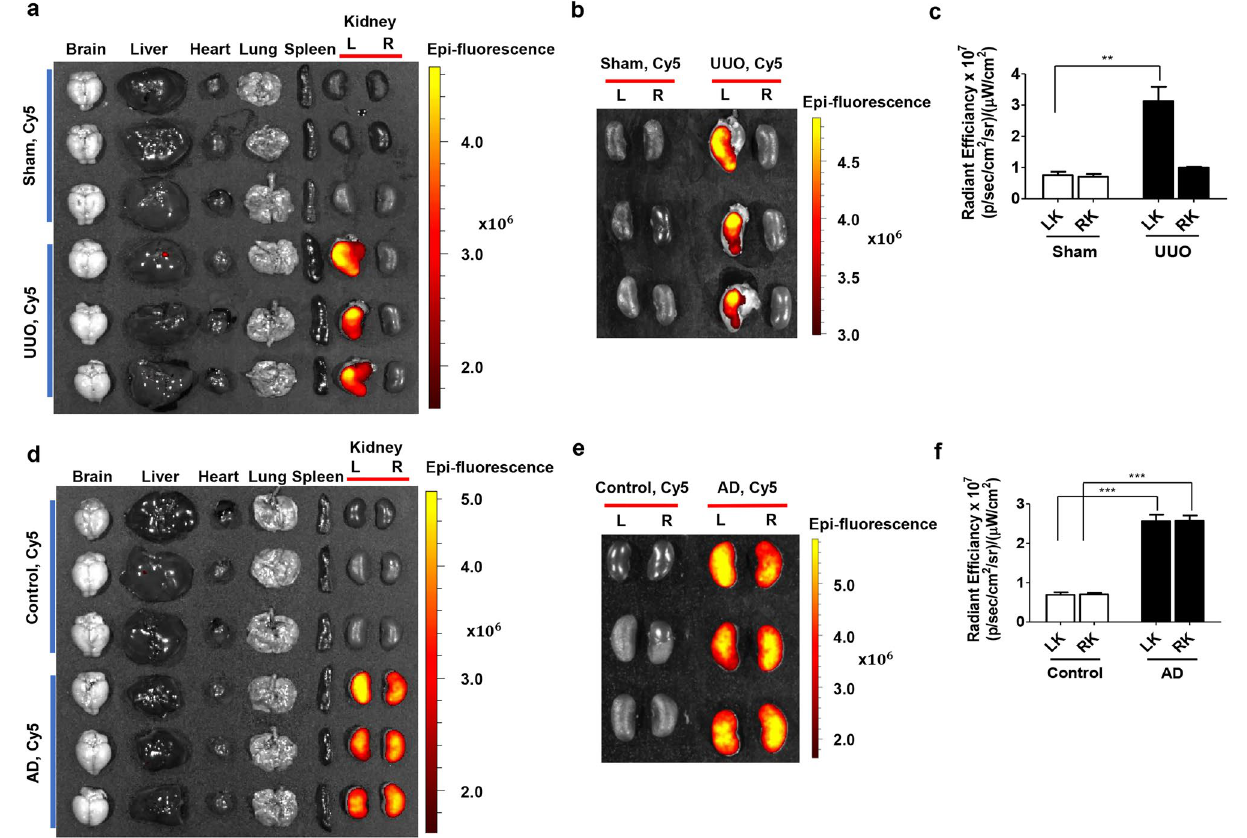
Figure 5. In vivo biodistribution of Cy5-labeled SAMiRNA-AREG in murine UUO- or AD-induced model of renal fibrosis. ( a ) Mice subjected to sham operations or 1 week after UUO were administered Cy5-labeled SAMiRNA-AREG via i.v. injection. Ex vivo fluorescent imaging was performed on organs including the brain, liver, heart, lung, spleen, and kidneys (L, obstructed, R, unobstructed) 48 h after the injection of Cy5-labeled SAMiRNA-AREG to sham or UUO mice, showing the Cy5 signal confined to the renal region. ( b ) Ex vivo fluorescent imaging of Cy5 signal from sham or UUO kidneys 48 h after the injection of the Cy5-labeled SAMiRNA-AREG. ( c ) Quantification of fluorescence intensity in the obstructed (LK) or unobstructed (RK) kidneys. ( d ) Mice fed a normal diet or 1 week of AD were subcutaneously injected with Cy5-labeled SAMiRNA- AREG. Ex vivo fluorescent imaging was performed on organs including the brain, liver, heart, lung, spleen, and kidneys 48 h after the injection of Cy5-labeled SAMiRNA-AREG to control or AD mice, showing the Cy5 signal confined to the renal region. ( e ) Ex vivo fluorescent imaging of Cy5 signal derived from control kidneys or AD model kidneys 48 h after the injection of Cy5-labeled SAMiRNA-AREG. ( f ) Quantification of fluorescence intensity of the kidneys in control and AD mice. The values in each panel represent the mean ± SEM of a minimum of three mice subjected to UUO or AD. ** p < 0.01, *** p < 0.001 compared to UUO (LK) or AD (LK or RK) (Fig. 6c,d). Upon kidney injury, adhesion molecules such as VCAM-1 and ICAM-1 were expressed to recruit inflammatory cells to the kidney injury site, followed by diffusion through vascular leaks. The mRNA expres- sion of VCAM-1 and ICAM-1 was increased in UUO- or AD-treated kidneys, but SAMiRNA-AREG treatment significantly reduced their expression (Fig. 6c,d). SAMiRNA‑AREG inhibits AREG expression and EGFR phosphorylation in renal fibrosis mod‑ els. We next determined whether SAMiRNA-AREG regulated EGFR phosphorylation, which is a critical mediator of renal fibrosis and acts as a receptor of AREG. Previous studies confirmed the upregulation of EGFR in renal fibrosis models 28,29 . Moreover, AREG is known to activate EGFR, which amplifies profibrotic down- stream signals 17 . IHC staining of AREG showed decreased AREG expression in the SAMiRNA-AREG-treated UUO- or AD-induced mice compared to the UUO or AD mice in which SAMiRNA-AREG was not injected (Fig. 7). We further investigated whether SAMiRNA-AREG influenced EGFR phosphorylation. The IHC stain- ing results showed increased EGFR phosphorylation at Tyr992 in the UUO and AD mouse models, which was reduced by SAMiRNA-AREG treatment (Fig. 7). These results indicated that SAMiRNA-AREG attenuated renal fibrosis by inhibiting AREG and EGFR activation.